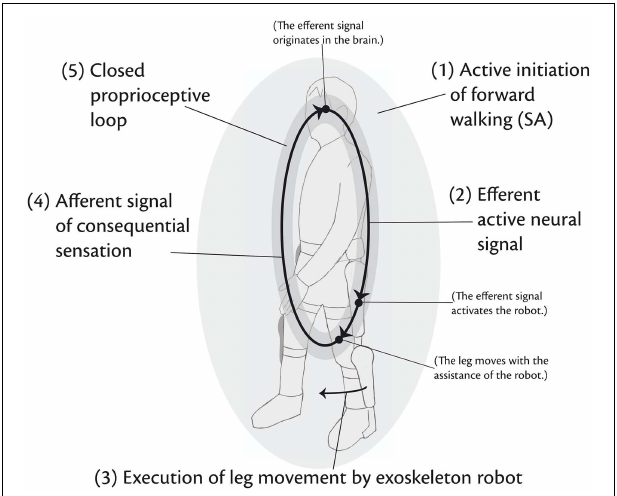
FIGURE 1 | SA initiating the proprioceptive loop. Based on “SA of forward walking” (1), an efferent active neural signal of the intended motion is released (2). The robotic device (in this example a lower-limb exoskeleton robot) detects the signal and supports the execution of leg movement (3) so that an afferent signal of consequential sensation goes back to the brain and signals that a motion has been executed successfully despite of the impairment (4). The closed proprioceptive loop of physical interaction (5) is supposed to enhance neurorehabilitation of the brain. Contrary to locating SA in the brain, conscious acts are regarded here as acts of the entire agent comprising the central nervous system as well as the